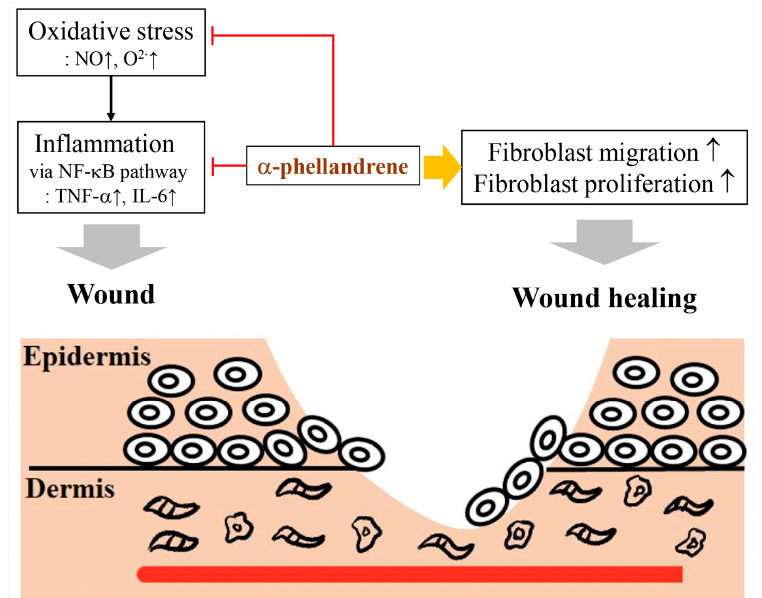
Figure 4. 1,8-cineol downregulates LPS-induced inflammation by blocking both NF- κ B transloca- tion and JNK pathway activation (Modified from Greiner et al. 2013 [68]). 1,8-cineol prevents the separation of I κ B and NF- κ Bp65/p55 and then blocks NF- κ B translocation from the cytoplasm to the Figure 9. α -phellandrene promotes wound healing by inhibiting oxidative stress and inflammation, nucleus, thus acting as a transcription factor for the expression of inflammation-related cytokines in addition to stimulating wound healing via potent fibroblast activation (modified from de Christo such as TNF- α and Scherer et al. 2019 [93]). ↑ : increasing;